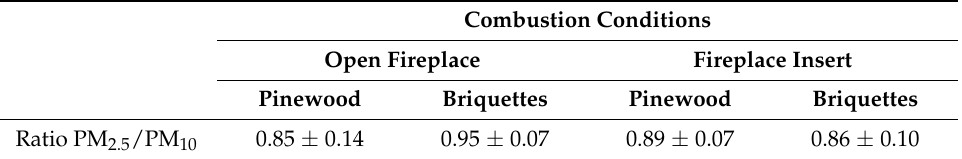
Table 4. PM 2.5 /PM 10 ratios for the studied combustion settings. Combustion Conditions